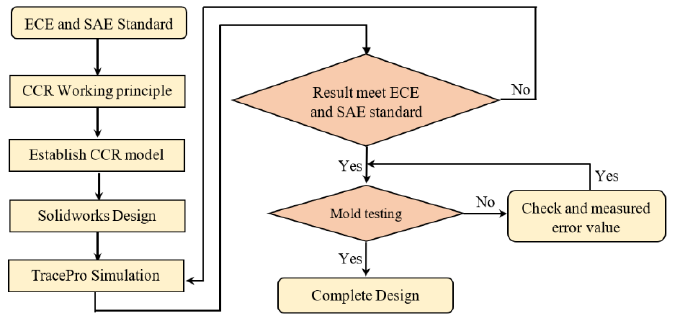
Figure 13. The designing flow chart of CCR used for SuperPin Plus .